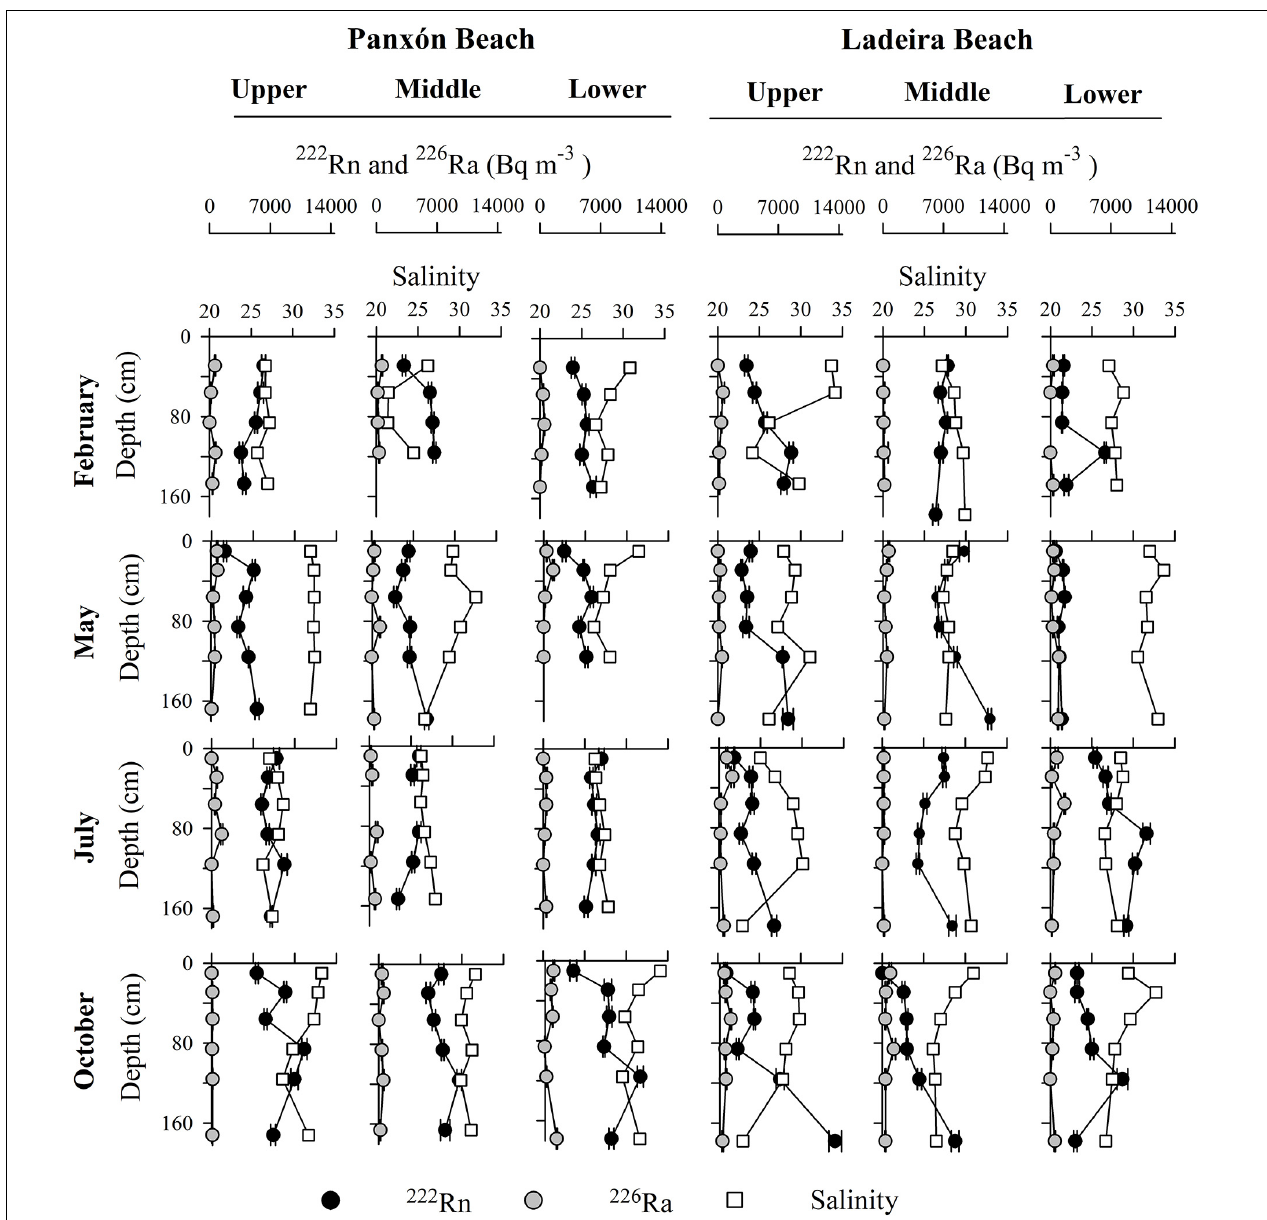
FIGURE 4 | Vertical distribution of porewater salinity, 222 Rn and 226 Ra activities (Bq m - 3 ) during each sampled month, beach and station. Uncertainties for the x -axis are also represented for 222 Rn and 226 Ra